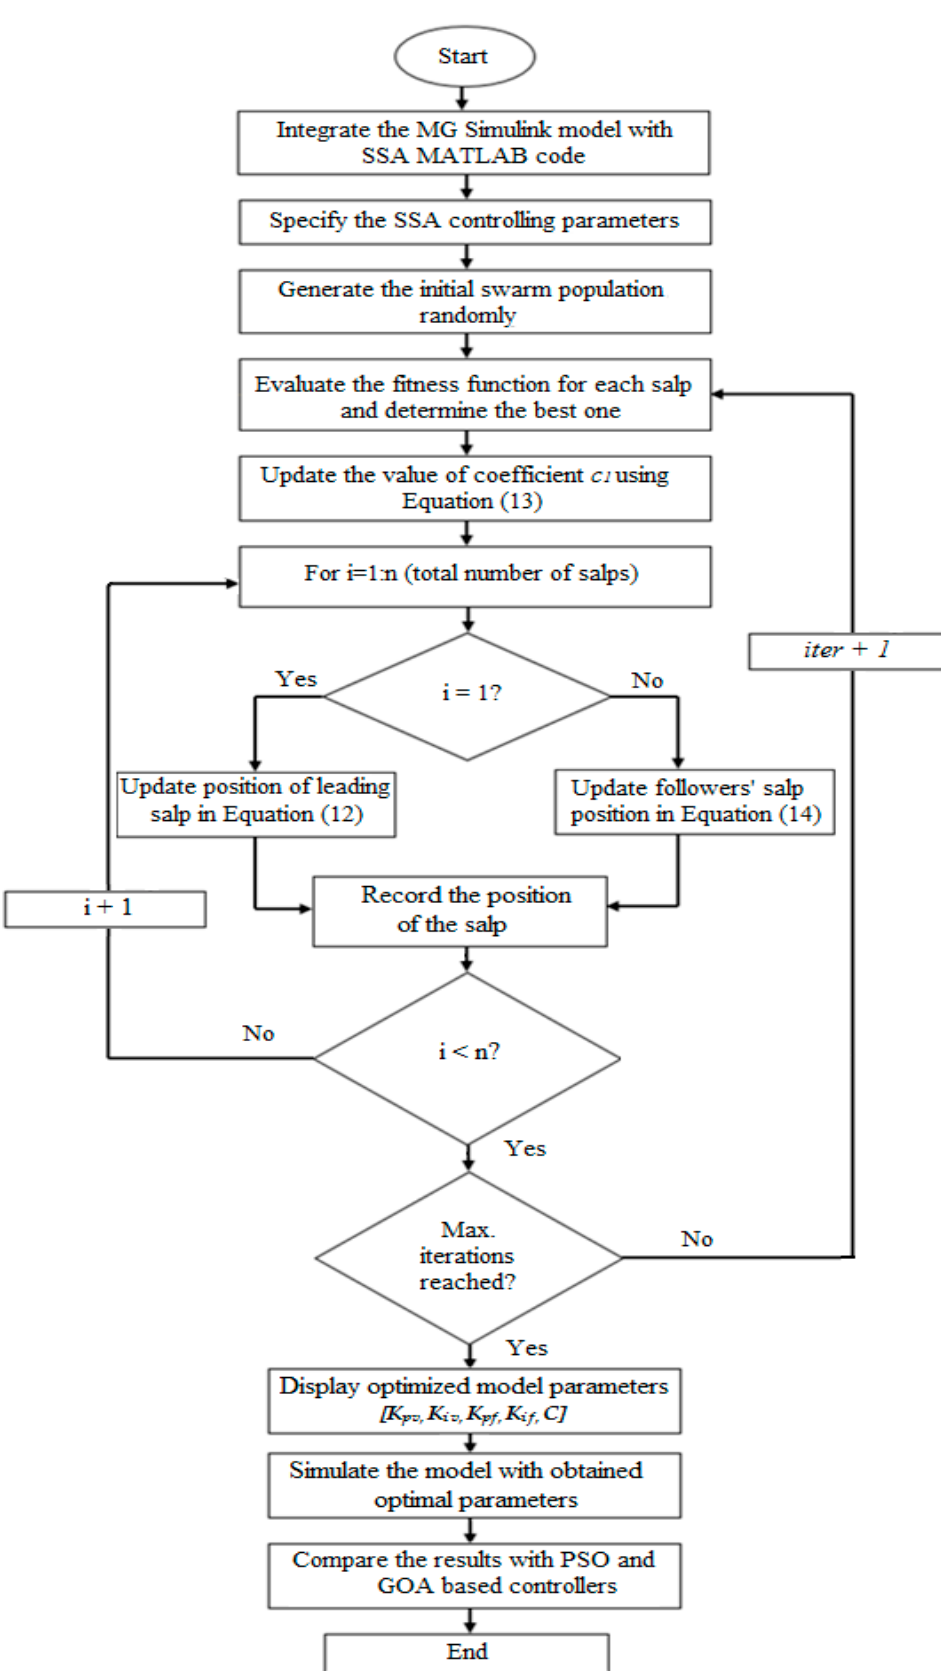
Figure 5. Proposed SSA based optimal plus integral (PI) parameter selection in studied islanded MG.